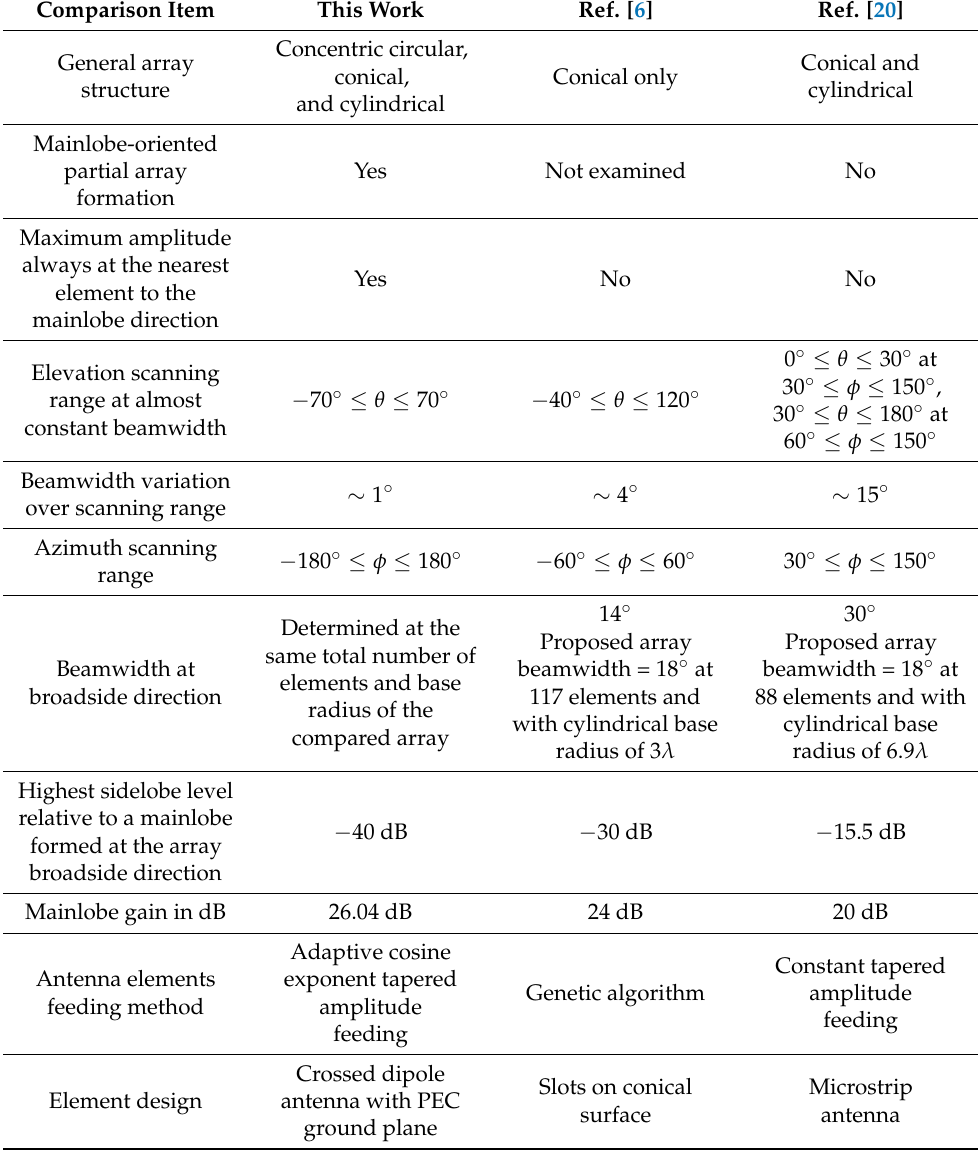
Table 6. Simulation parameters for frontal-oriented mainlobe partial CSC 4 using crossed dipole as an antenna